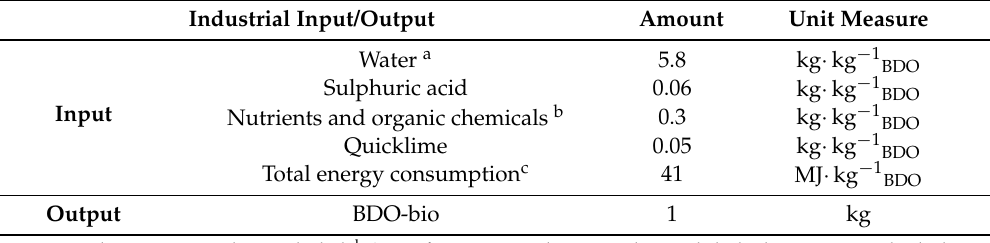
Table 2. Data input/output for 1 kg of bio-based BDO, related to the whole industrial phase: dilute sulphuric acid pre-treatment, enzymatic hydrolysis, C5andC6 co-fermentation and BDO